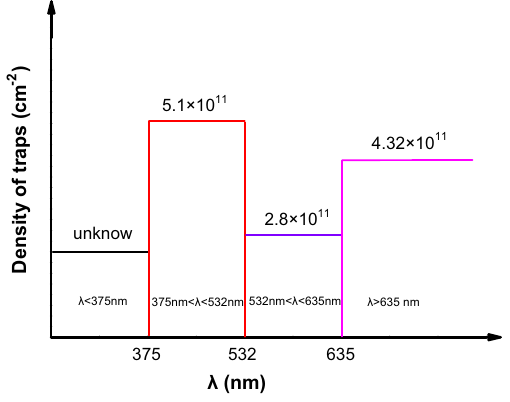
Figure 9. Trap distribution in